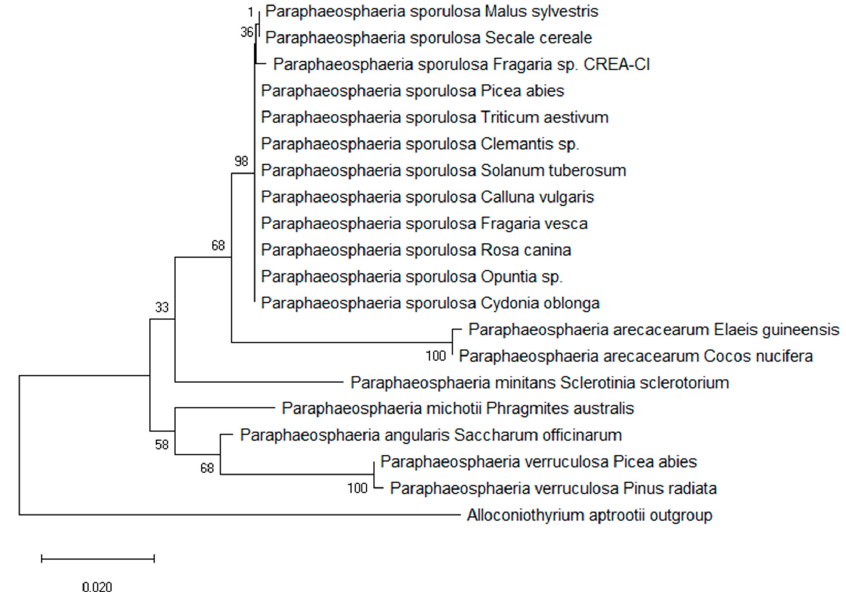
Figure 1. Phylogenetic analysis. Unrooted phylogenetic tree calculated from partial ITS regions (ITS1, 5.8S gene and ITS2) of rDNA of Paraphaeosphaeria species. Paraphaeosphaeria sporulosa Fragaria sp. CREA-CI indicates the CP-1 isolate obtained by the authors. The Alloconiotirium aptrootii sequence was used as the